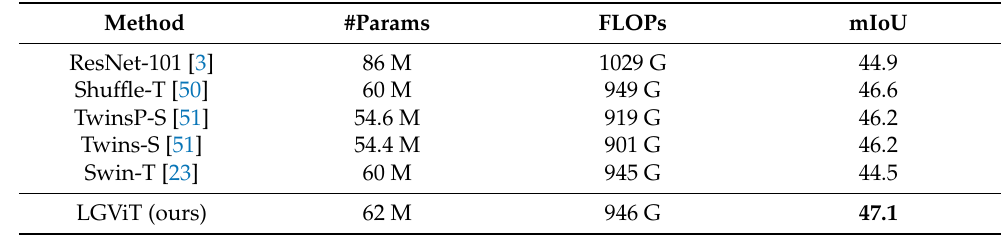
Table 5. Performance comparison of semantic segmentation task on the ADE20K dataset for different models. The FLOPs are computed on 2048 × 512